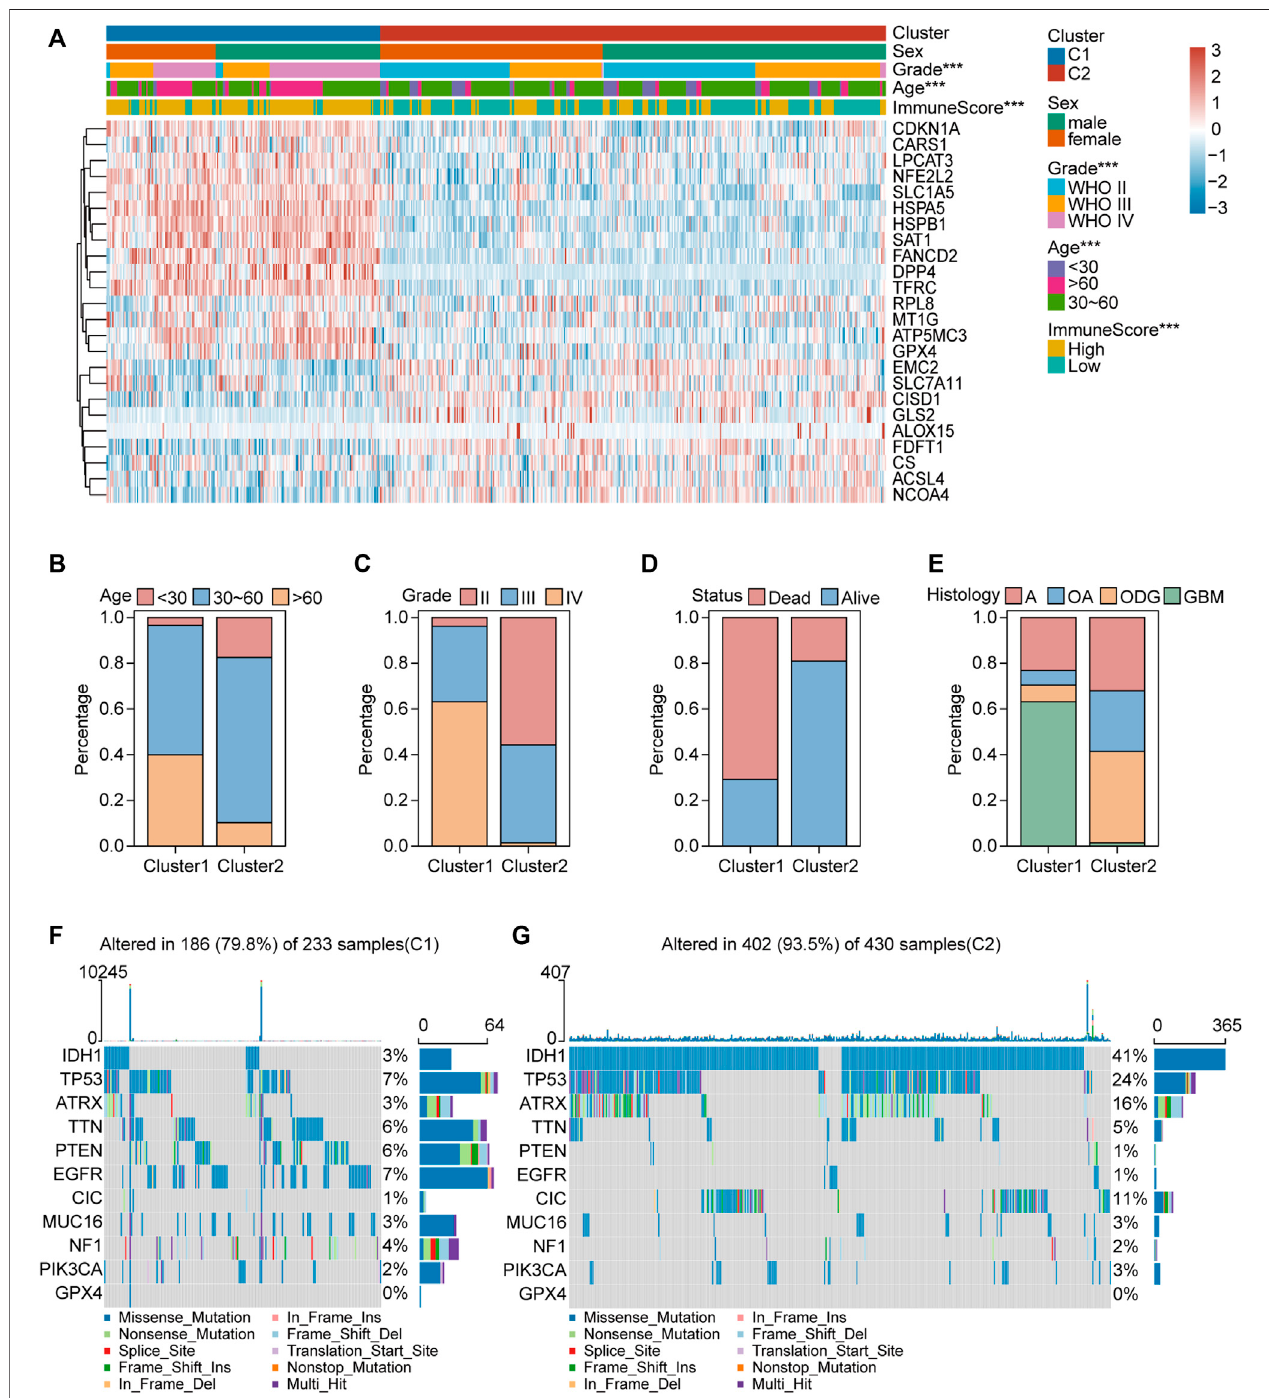
FIGURE3| Clinicalfeaturesandsomaticlandscapesoftwoferroptosis-relatedsubtypes. (A) Heatmapvisualizedthedistributionofsex,age,grade,immuneScore between the two ferroptosis-related subtypes. * p < 0.05; ** p < 0.01; *** p < 0.001. (B – E) Histograms depicted the differences of age, grade, status and histology betweentwoferroptosis-relatedsubtypes. (F,G) Oncoplotdisplayingthesomaticlandscapeofgliomacohortoftwoferroptosis-relatedsubtypes.Genesareorderedby their mutation frequency, and samples are ordered according to disease histology as indicated by the annotation bar (bottom). Side bar plot shows log10 transformed Q-values estimated by MutSigCV. Landscape of mutation pro fi les in OC samples. Mutation information of each gene in each sample was shown in the waterfall plot, where different colors with speci fi c annotations at the bottom meant the various mutation types. The bar plot above the legend exhibited the number of mutation burden.